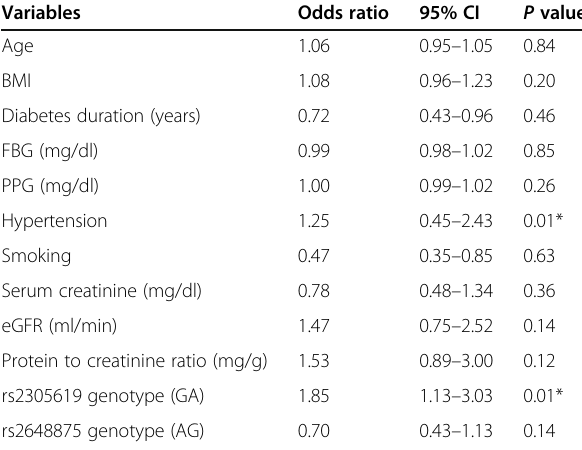
Table 6 Logistic regression analysis for the association among diabetic kidney disease, genetic variants, and confounding risk factors in diabetes mellitus patients Variables